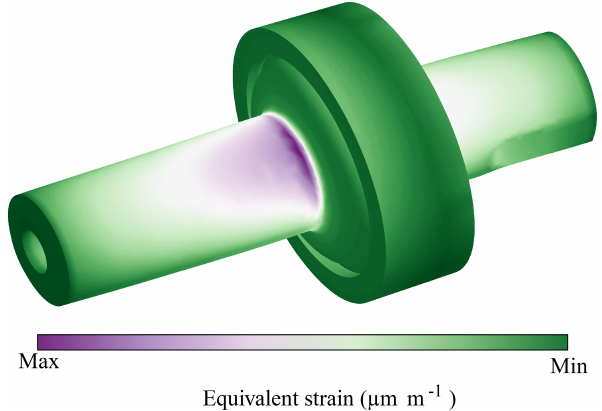
Figure 2. Simulation results for longitudinal mode shape of the sonotrode.